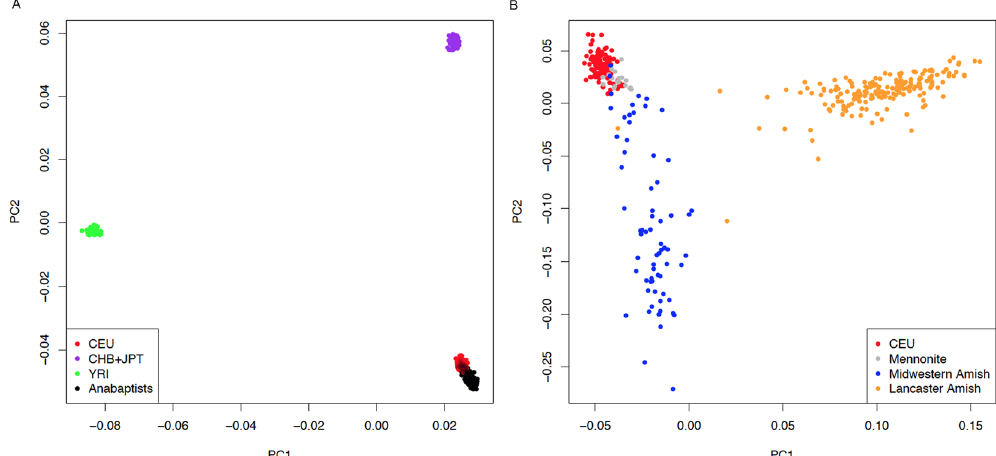
Figure 3. Plots of the first two principal components derived from the AGRP samples. ( A ) AGRP samples (black dots) are plotted along with European (CEU, red dots), Asian (CHB + JPT, violet dots), and African (YRI, green dots) samples taken from HapMap phase 3. ( B ) Mennonite (grey dots), Midwestern Amish (blue dots), and Lancaster County Amish (orange dots) within the AGRP, and CEU (red dots) from HapMap phase 3.